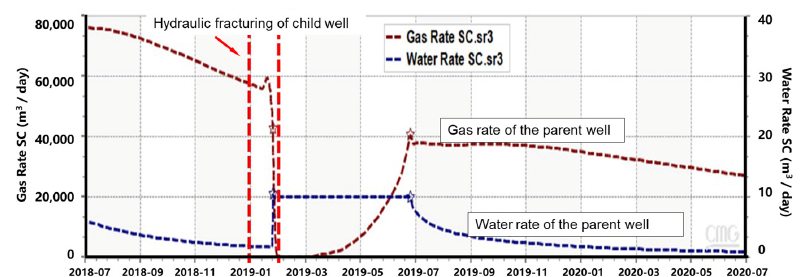
Figure 14. Gas and water rates of the parent well before and after hydraulic fracturing of child well.